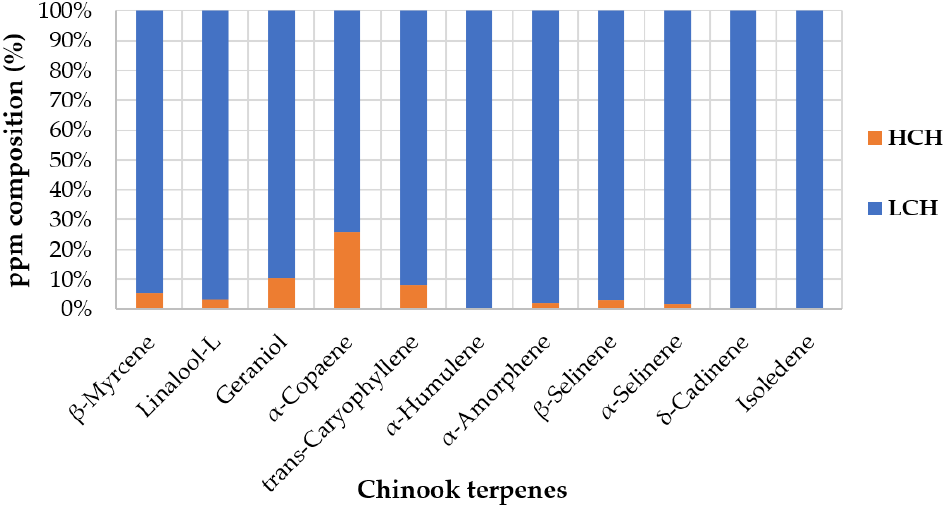
Figure 3. Hundred percent stacked column representation of the average ppm data from Table 6.